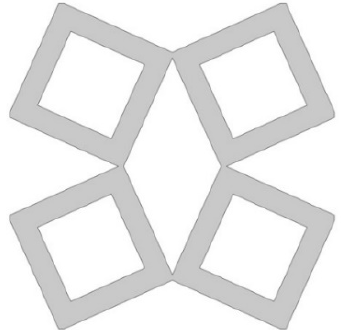
Figure 3. The obtained unit cell for d 1 = 0.30.